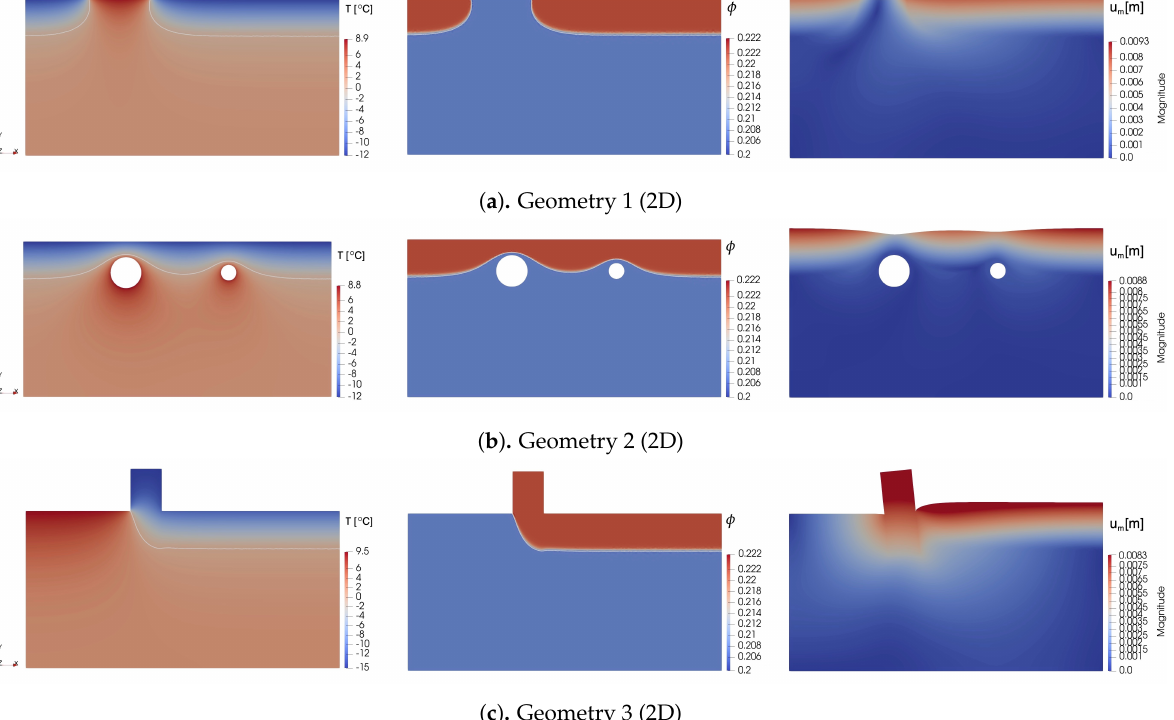
Figure 7. Test 2 for a two-dimensional problem. Temperature, porosity, and displacement fields at the final time (from left to